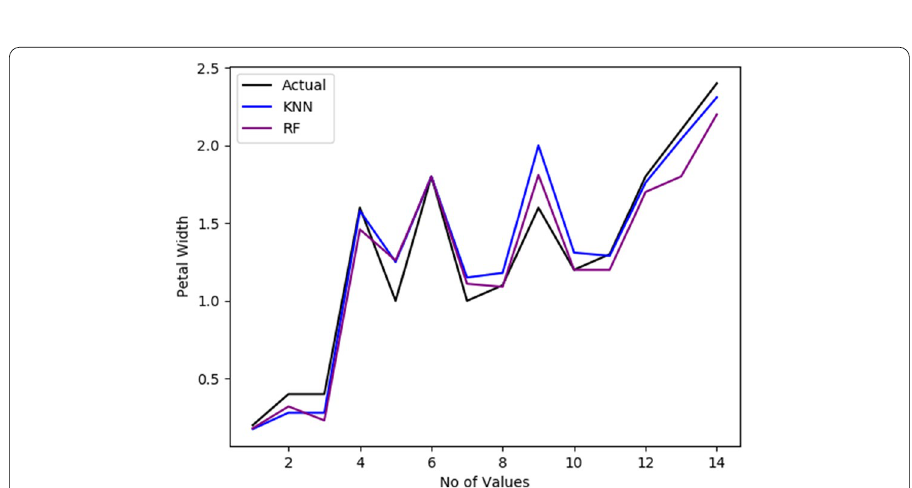
Fig. 3 Comparison of KNN and RF imputed values with the actual values on Petal width at 15%